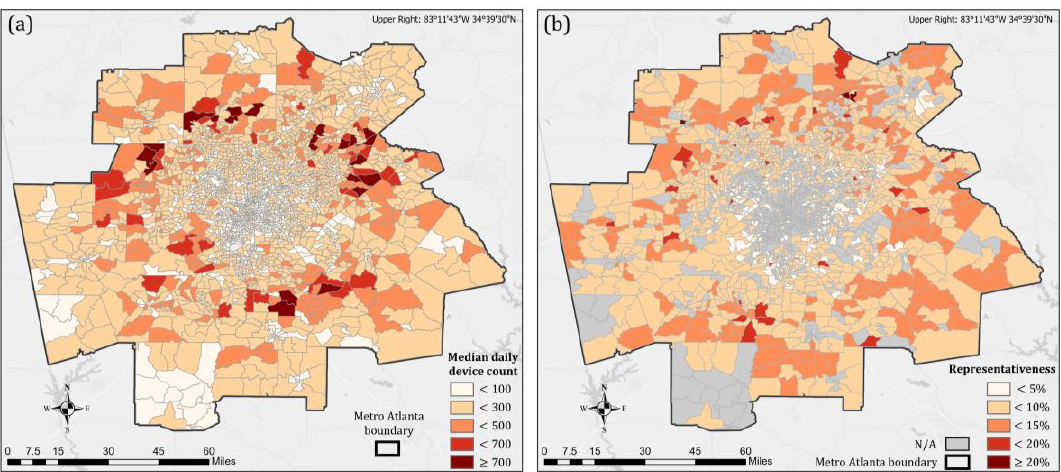
Figure 2. ( a ) The median daily device count from January 1 to August 31 at CBG level in Metro Atlanta; ( b ) Representativeness of each CBG in Metro Atlanta. The representativeness is defined as the ratio of the median daily device count to the population from the ACS 2014–2018 estimates. CBGs annotated with “N / A” fail to meet the requirements in the preprocessing steps and therefore are removed. CBG boundaries are derived from 2019 TIGER/Line Shapefiles.